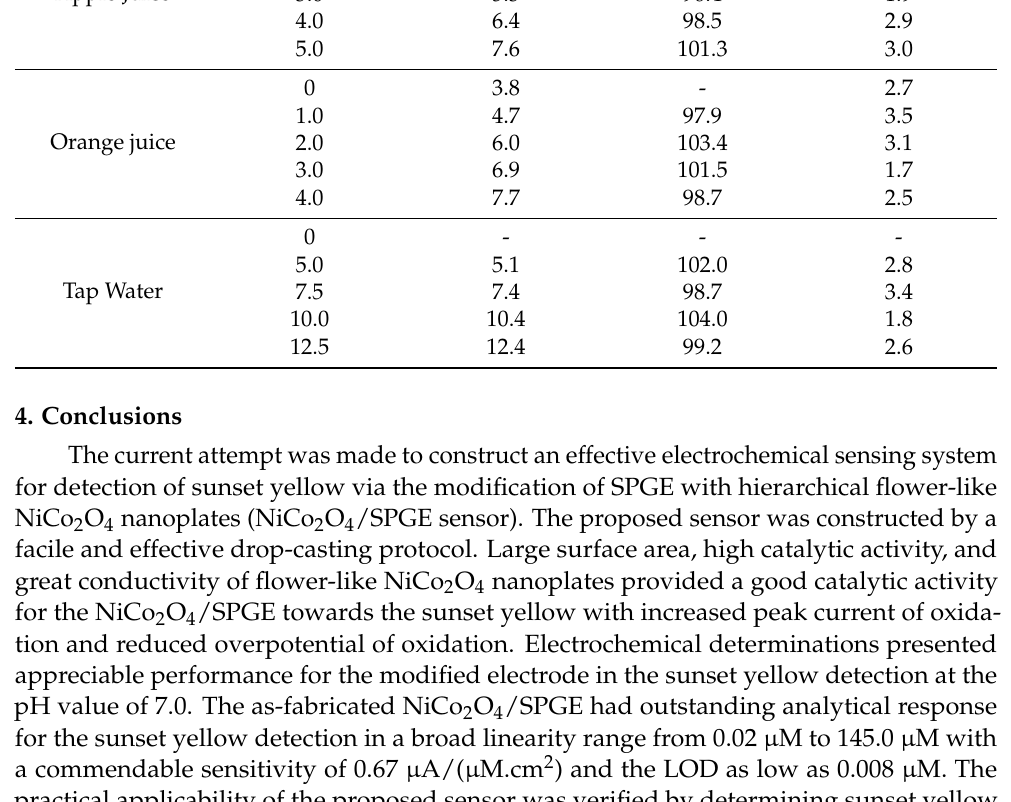
Table 2. Voltammetric sensing of sunset yellow in real specimens using NiCo 2 O 4 /SPGE. All concen- trations are in µ M ( n = 5). Sample Spiked Found Recovery (%) R.S.D. (%) 0 2.5 Apple Juice